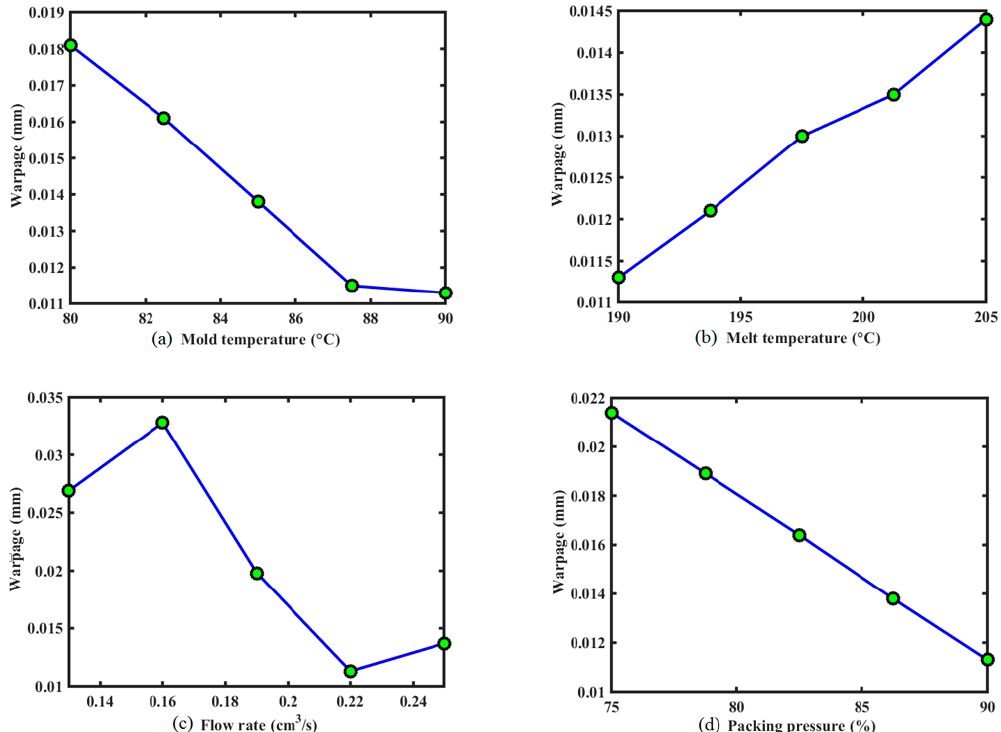
Figure 10. Cont. Figure 10.